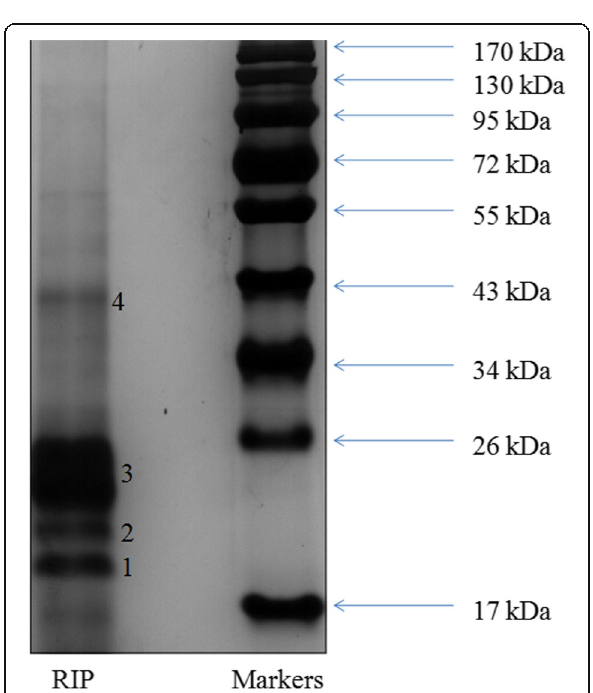
Fig. 1 SDS-PAGE profiles of Radix isatidis protein (RIP)